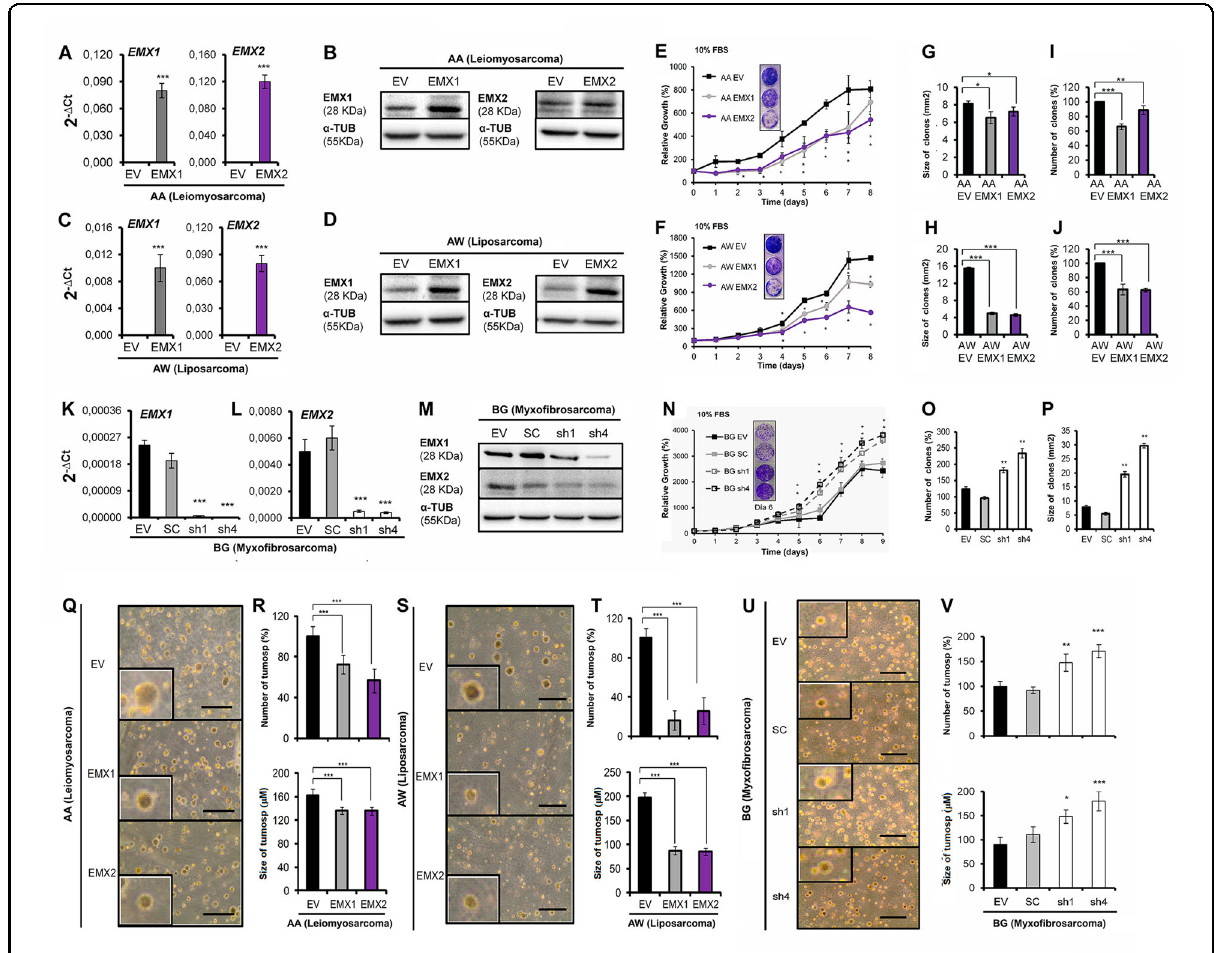
Fig. 1 Effect of EMX1 and EMX2 expression levels in cell models expressing different levels of EMX proteins. Ectopically transfected empty vector (EV) or EMX1 or EMX2 cDNAs. In A and C , the expression levels were measured by qRT-PCR and in B and D by western blottings in the primary lines of AA sarcoma ( A , B ) and AW ( C , D ). E – J Effect of EMX1 and EMX2 overexpression on the proliferative and colony-forming capacities of sarcoma cell lines. E , F Growth curves of the overexpression of EMX1 in the AA ( E ) and AW ( F ) sarcoma lines. Inside, images of crystal violet-stained growth plate wells on the last day of the experiment. G – J The result of the clonability test assessing the effect of overexpression of EMX on the size and number of colonies in the AA ( G , I ) or AW ( H , J ) cell lines. G , H Graph of the size of the colonies. I , J Graph of the number of colonies. K , L Validation of cellular models of silencing of EMX1 and EMX2 expression levels by two independent shRNAs, sh1 and sh4, in the sarcoma line BG. M Protein levels of EMX1, EMX2, and the endogenous control α -tubulin ( α -TUB) in the BG cell line expressing the shRNAs against EMX. N – P Effect of the reduction of EMX1 and EMX2 on the proliferative and colony-forming capacities in the sarcoma BG cell line. N Growth curves of the silencing models of EMX1 and EMX2 of the BG sarcoma line under the conditions of 10% FBS. Inside, images of crystal violet-stained growth plate wells on a given day of the experiment. O , P Clonability assay of the silencing models of the BG sarcoma line. O Graph of the number of colonies. P Size of the colonies. Q – V Effect of the EMX1 and EMX2 levels on anchor-independent growth. Q , S , U Representative images of the colonies embedded in the agar in the AA ( Q ), AW ( S ), or BG ( U ) lines with different levels of EMX protein. R , T , and V Percentage of the number of colonies and the mean size of the colonies for the AA ( R ), AW ( T ), or BG ( V ) cell lines with different levels of EMX protein. The horizontal bar corresponds to 500 mm. In all cases, the mean of three independent experiments is represented in triplicate ± SD. Statistical analysis was performed with Student ’ s t -test (* p < 0.05; ** p < 0.01; *** p < 0.001). In western blottings, a representative experiment of at least three independently performed experiments is shown. The endogenous control was α -TUB ( α